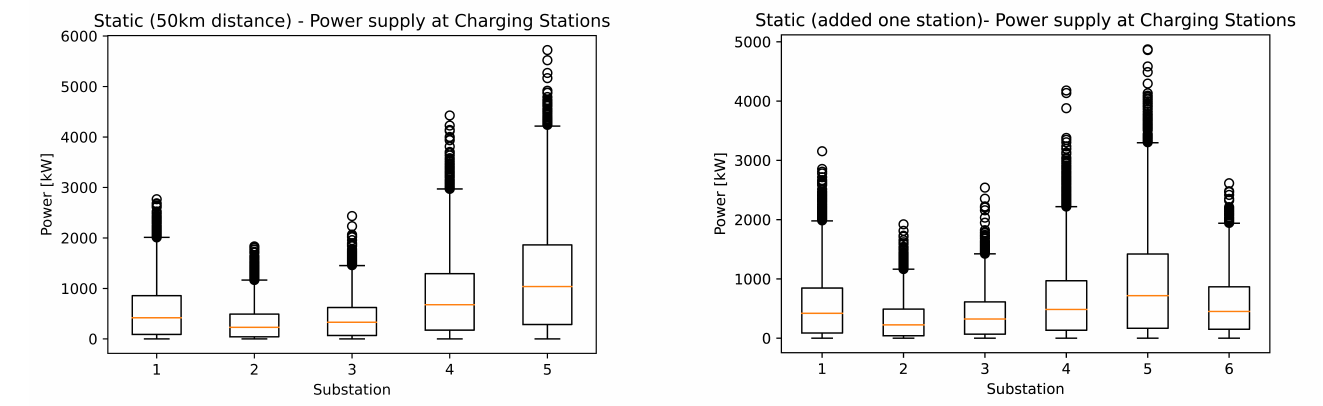
Figure 9. Static scenario charging power.